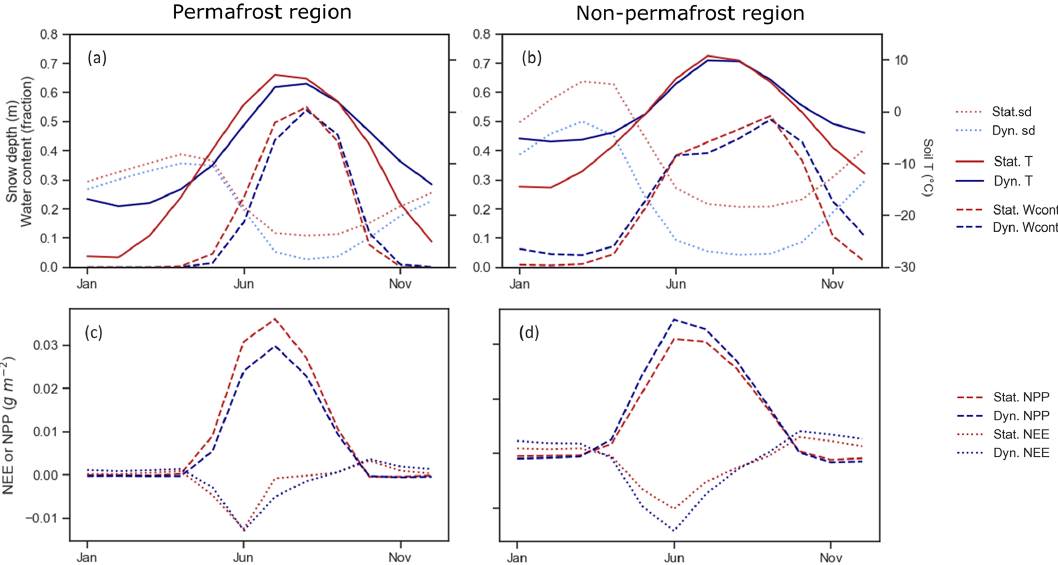
Figure 11. Seasonal dynamics of snow depth, soil temperature (25cm depth), and fractional soil water content within (a) and outside of the permafrost region (b) . Seasonal dynamics of NEE and NPP within (c) and outside of the permafrost region (d)